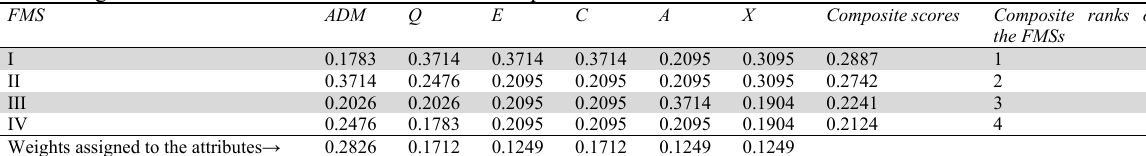
Ranks assigned to the alternatives and attributes of example 4